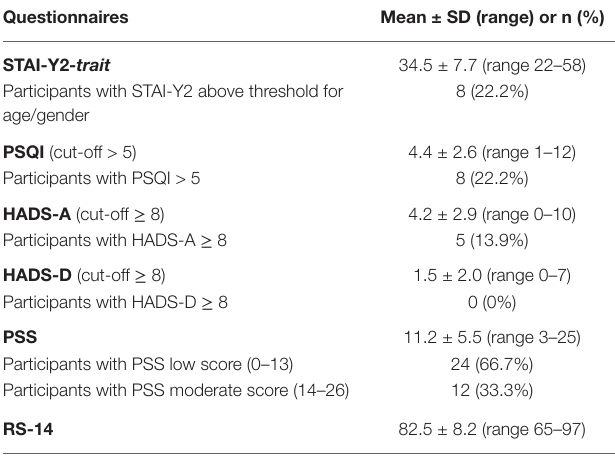
TABLE 2 | Demographical data (36 participants). TABLE 3 | Baseline questionnaires (36 participants).